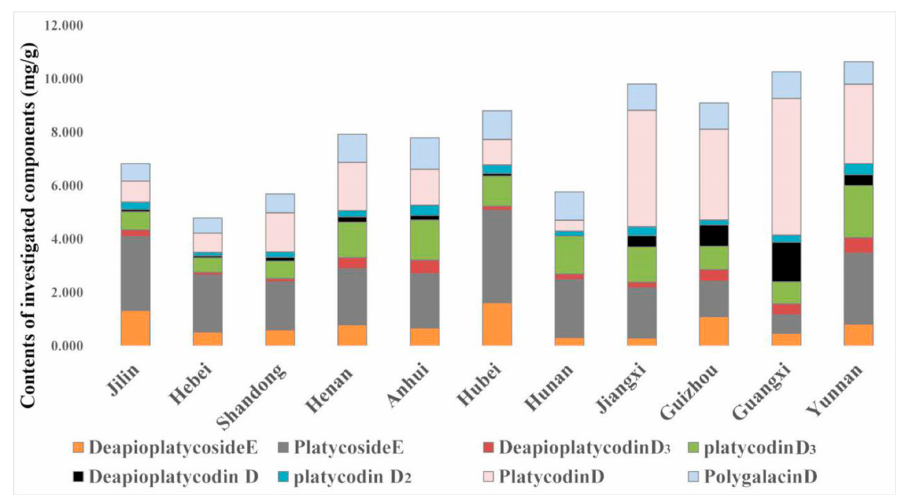
Figure 2. Comparison of eight investigated compounds in samples from 11 provinces.